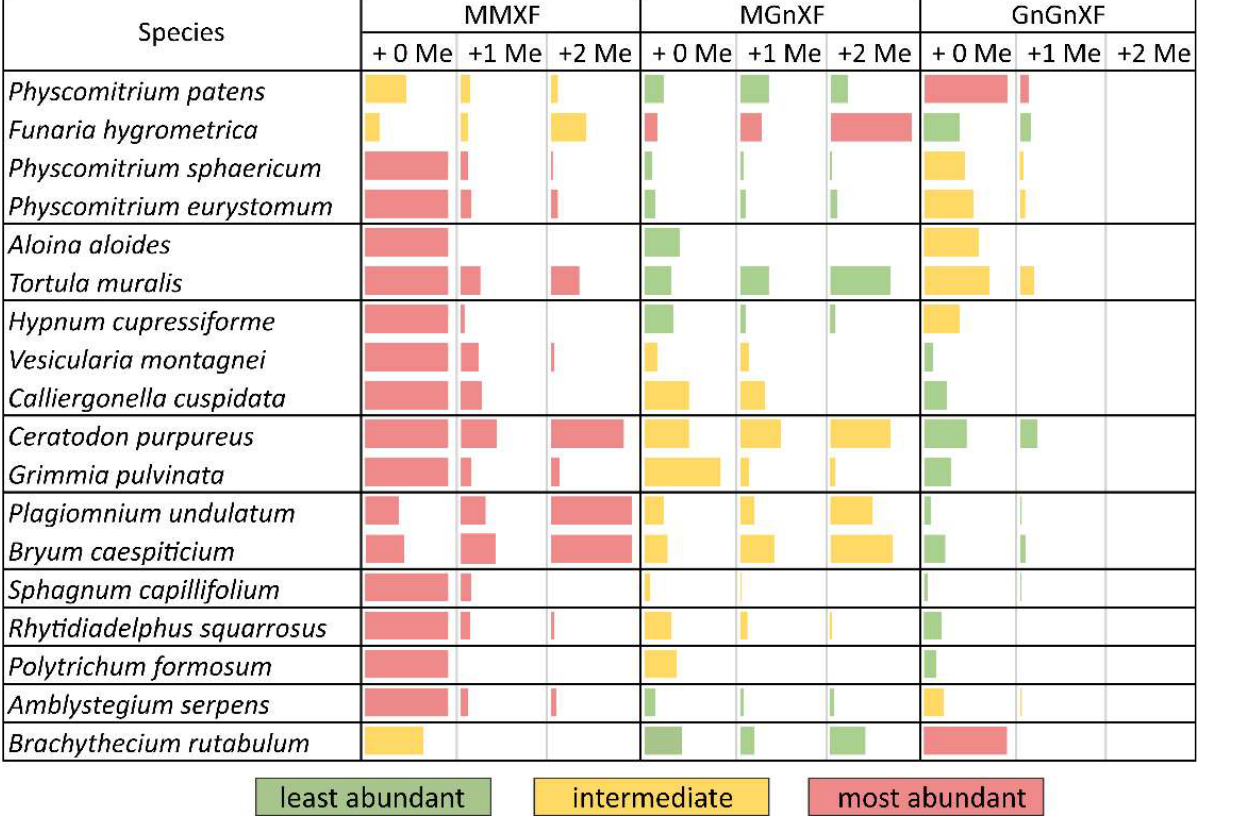
Figure 2. Glycan abundance in different moss species. Mosses from the same family are clustered together in separate boundaries. The abundance of MMXF, MGnXF and GnGnXF with their methylation is shown with coloured bars. The size of the bars is relative to the most abundant glycan from each species. Red indicates the most abundant glycan form. Physcomitrium patens was formerly known as Physcomitrella patens .